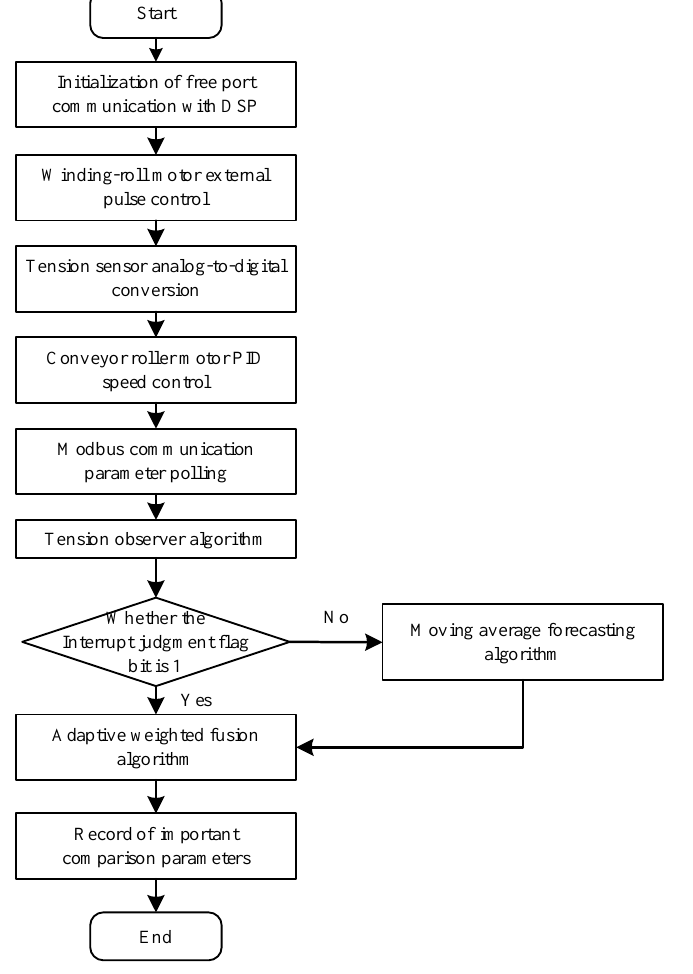
Figure 12. Flowchart of the PLC internal program.